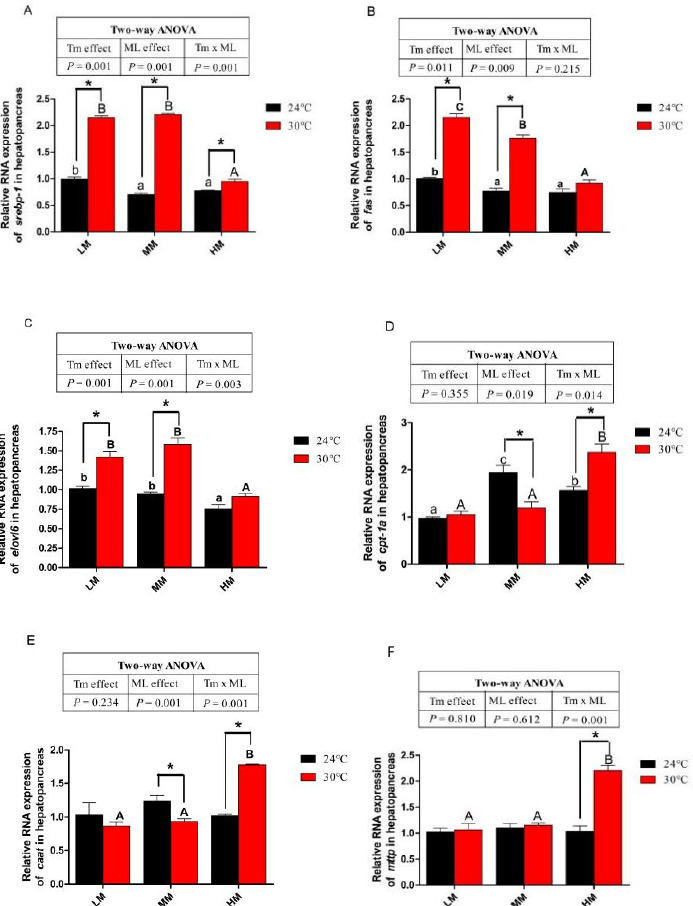
Figure 2. The lipid metabolism of juvenile E. sinensis fed the experimental diets at normal water temperature (24 ◦ C)/high water temperature (30 ◦ C). ( A ) srebp-1 : sterol-regulatory element binding protein 1; ( B ) fas : fatty acid synthase; ( C ) elovl6 : elongase of very-long-chain fatty acids 6; ( D ) cpt-1 α : carnitine palmitoyl transterase 1 α ; ( E ) caat : carnitine acetyltransferase; ( F ) mttp : microsomal triglyc- eride transfer protein. * means that there is a significant difference between different temperatures at the same dietary methionine level ( p < 0.05). The a, b and c indicate significant differences among crabs fed diets with different dietary methionine levels at normal temperature ( p < 0.05). The A and B indicate significant differences among crabs fed diets with different dietary methionine levels at high water temperature ( p <